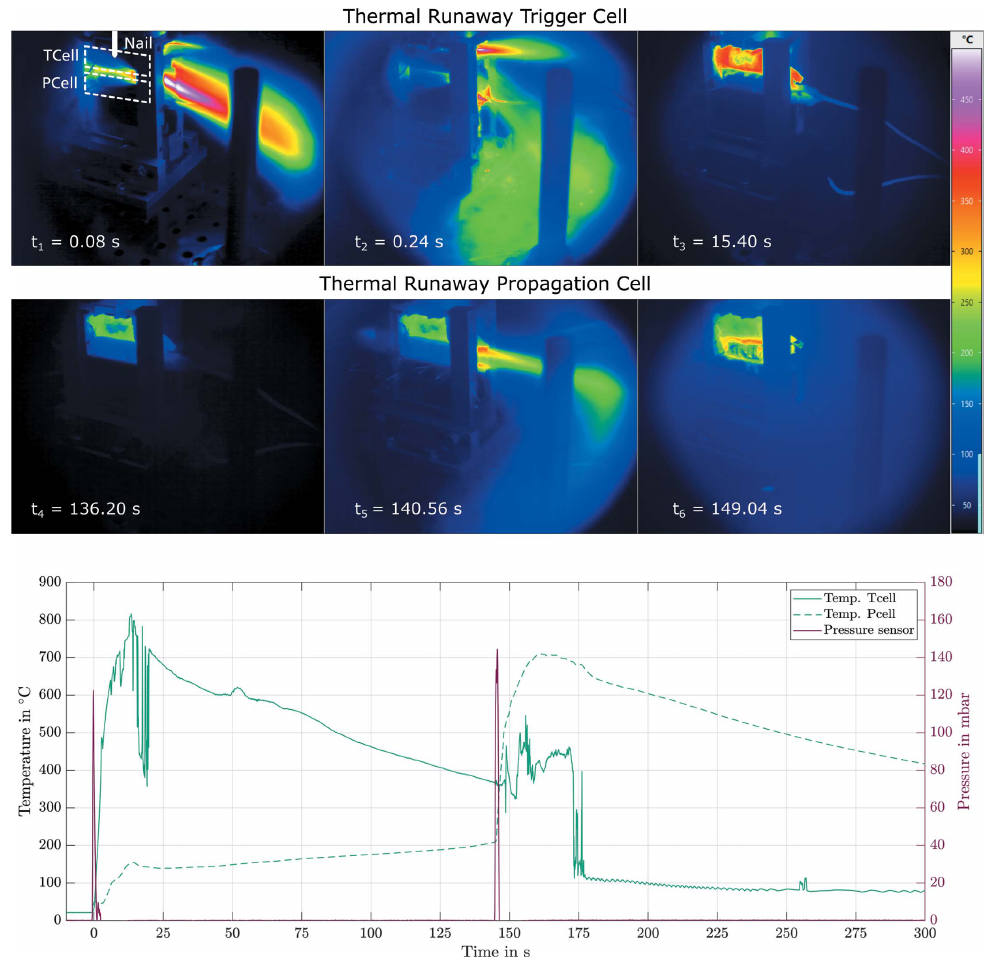
Figure 4 Thermal image of nail-triggered TR of a Molicel P42A cell with another cell mounted below it (Exp.2). The images show the venting process of the first cell and the heat-induced TR of the second cell. The time-synchronous recording of the different data sets enables a comparison with the temperature data of the thermocouple and the pressure differential recorded by the pressure sensor, among other